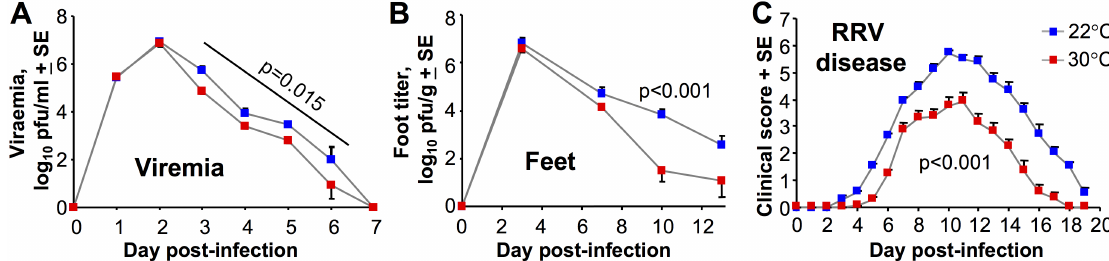
Fig 5. Affect of ambient temperature in the RRV model of alphaviral arthropathy. Mice were housed at 22˚C or 30˚C and were infected s.c. in the pectoral region with RRV. (A) Viremia. (Statistics by repeat measures ANOVA for days 3–6, n = 5 mice per group). (B) Feet titers. (Statistics by Mann-Whitney U test, n = 5 feet from 5 mice per group). (C) Disease severity score. This is primarily a score of hind limb paralysis. (Statistics by repeat measures ANOVA, n = 5–10 mice per group, day